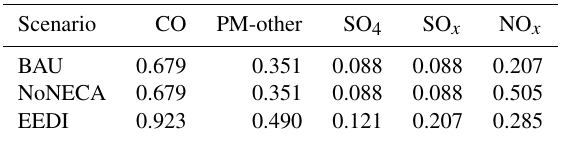
Table 2. Future scenario emissions: emission scaling factors used in the three scenarios for shipping emissions for the relevant air pol- lutants. PM-other includes EC, OC and mineral ash. The emission scaling factors give the respective emissions in 2040 in relation to the emissions in